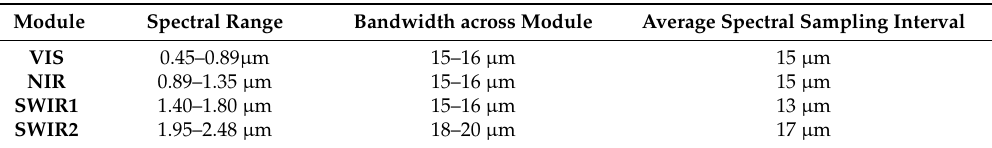
Table 1. The spectral configuration of the HyMap sensor is shown below for each of the four spectral modules containing 32 bands each, totaling 128 spectral